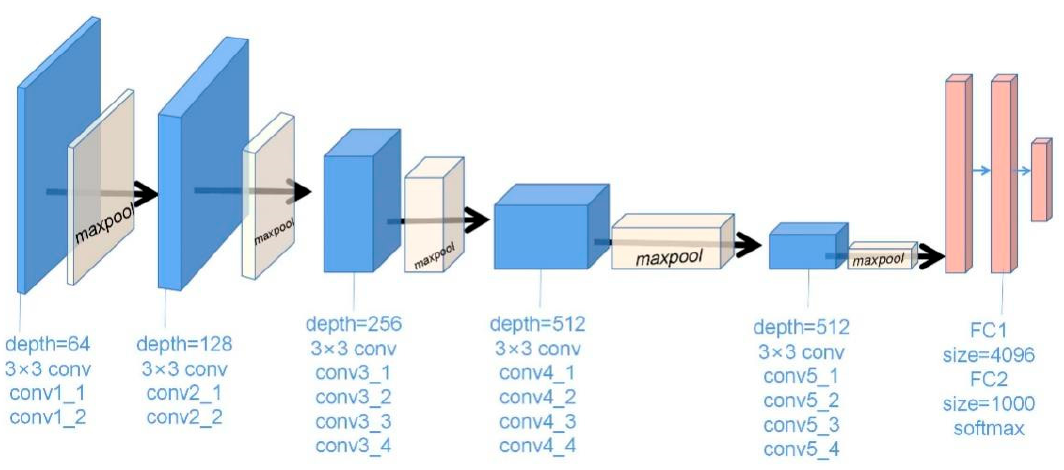
Figure 1. Architecture of the CNN-based VGG19 pretraining model.